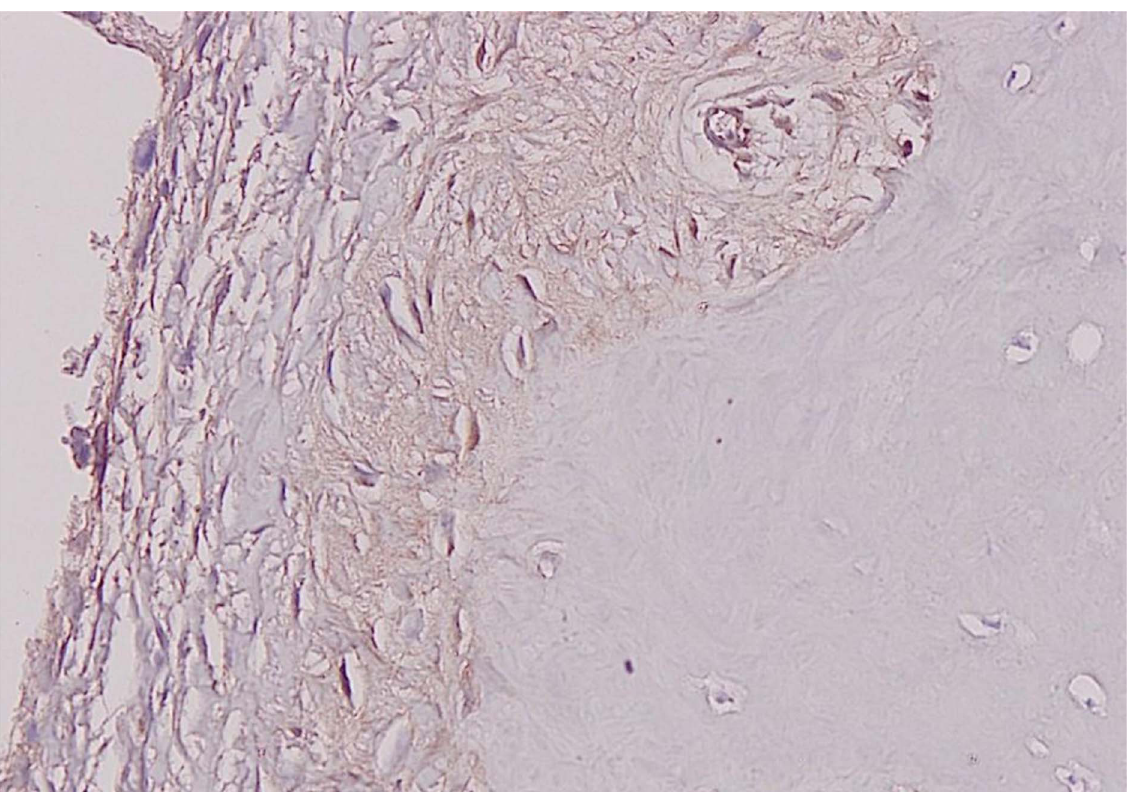
Figure 5. Immunohistochemistry staining result for TGF- b expression from an osteophyte graft, showing score +1 depicting present but weak immunoreactivity. Table 3. Prior studies of bone graft